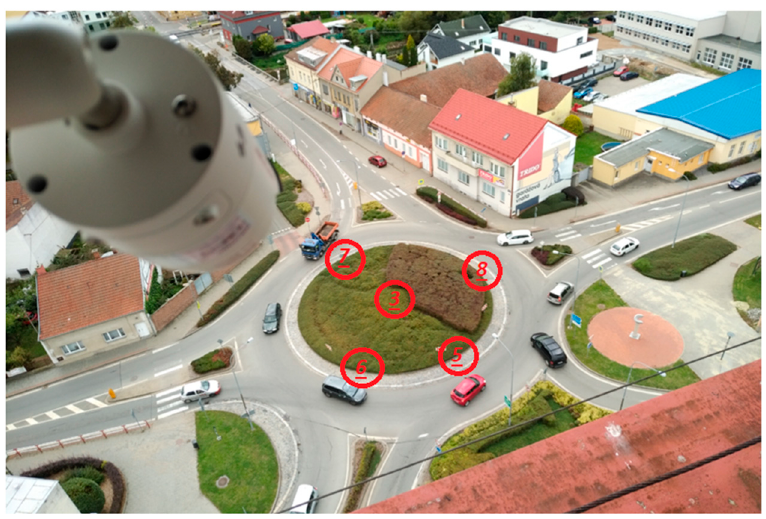
Figure 6. The camera scene over the roundabout, 3, 5, 6, 7, 8 refer to the locations of the microphones.